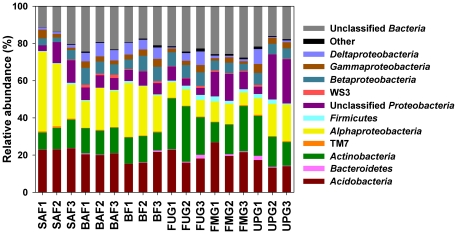
Relative abundances of phylogenetic groups in soils derived from the different grassland and forest sampling sites.Sample numbers indicating the different management types are given below the graph. A description of the samples is shown in Table 1. Phylogenetic groups accounting for ≤0.4% of all classified sequences are summarized in the artificial group ‘others’.